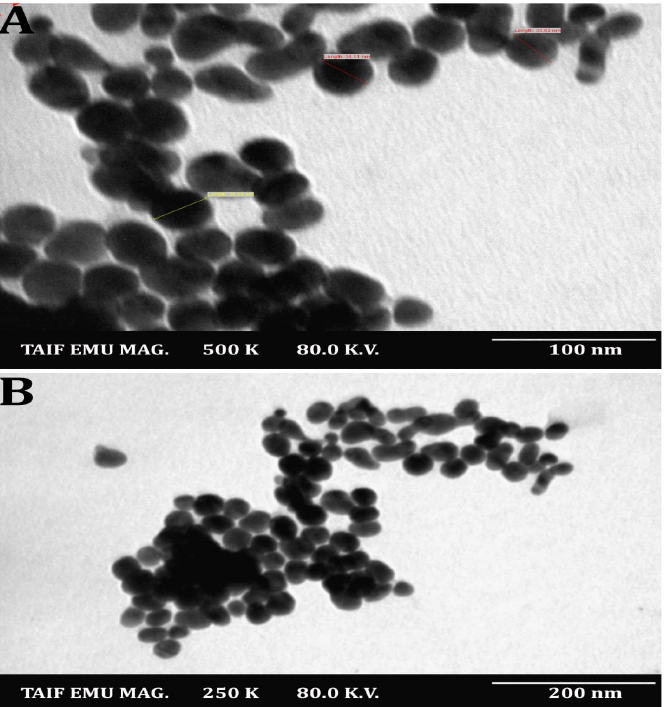
Figure 4. TEM images of the Streptomyces rochei MS 37-derived SNPs. Magnification power at 100 nm ( A ) and at 200 nm ( B ).